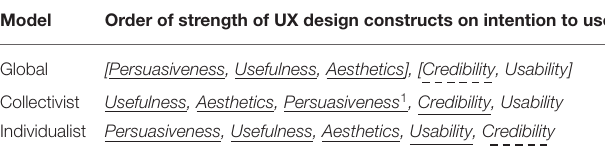
TABLE 6 | Determinants of the intention to use profile.